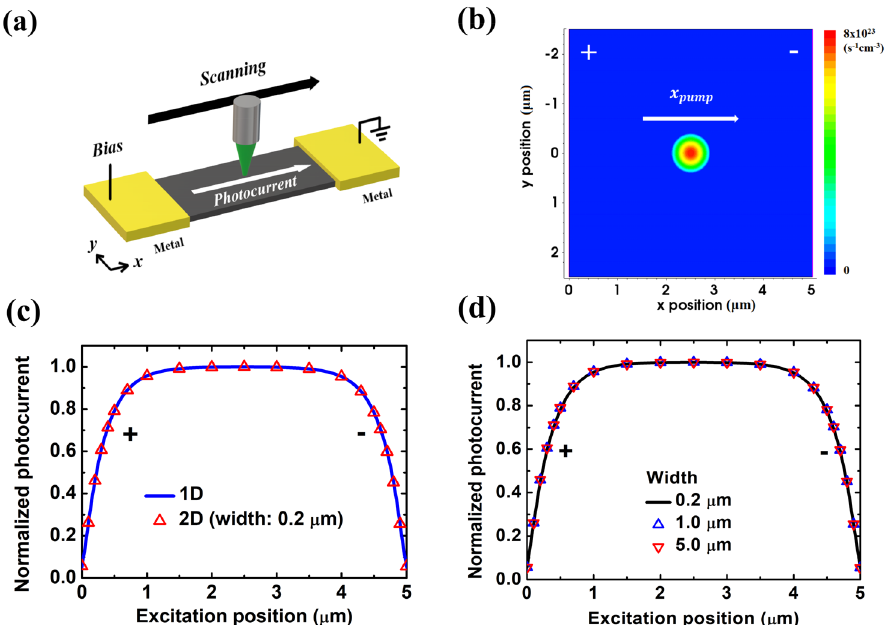
Figure 1. ( a ) Schematic of a SPCM setup in a two-terminal thin-film structure. ( b ) Mapping of 2D absorbed photon density per second, scanning across the channel. The anode is at x = 0 μm and the cathode is at x = 5 μm. ( c , d ) In ohmic-contact based devices. ( c ) Scanning photocurrent profile of the 0.2 μm wide case compared with that of the 1D transport structure. Our previous simulator was used in 1D simulation. ( d ) Scanning photocurrent profiles with different widths. *( a ) is created using Microsoft Paint 3D